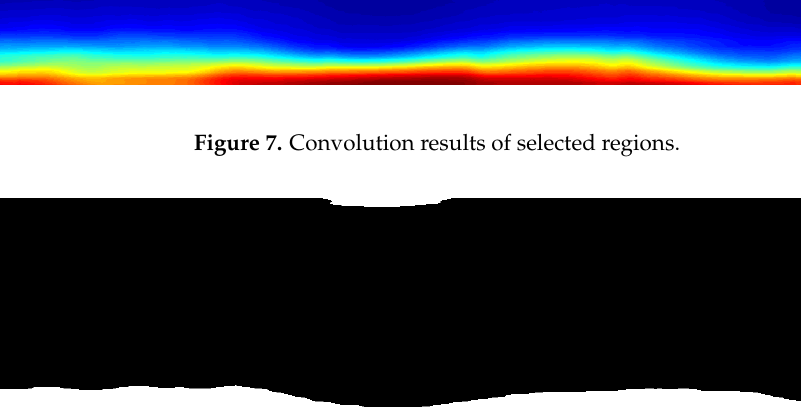
Figure 8. Binarization image of selected regions.